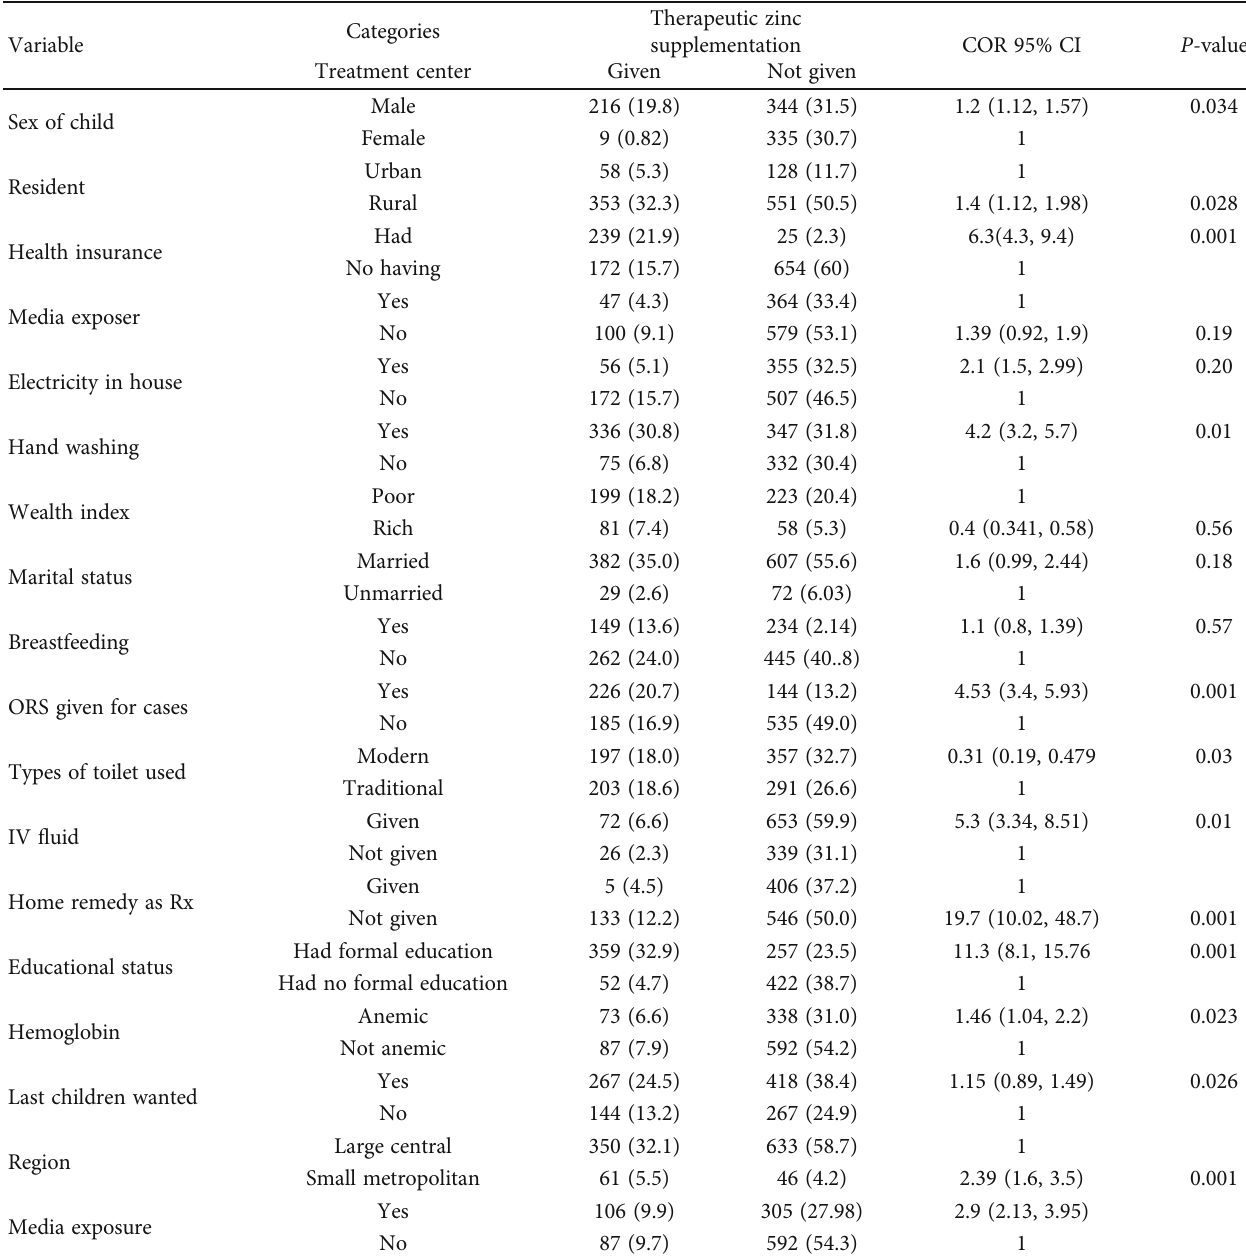
Table 3: Bivariables intended to be used in therapeutic zinc utilization for the management of acute diarrhea morbidity among under- fi ve children, EDHS